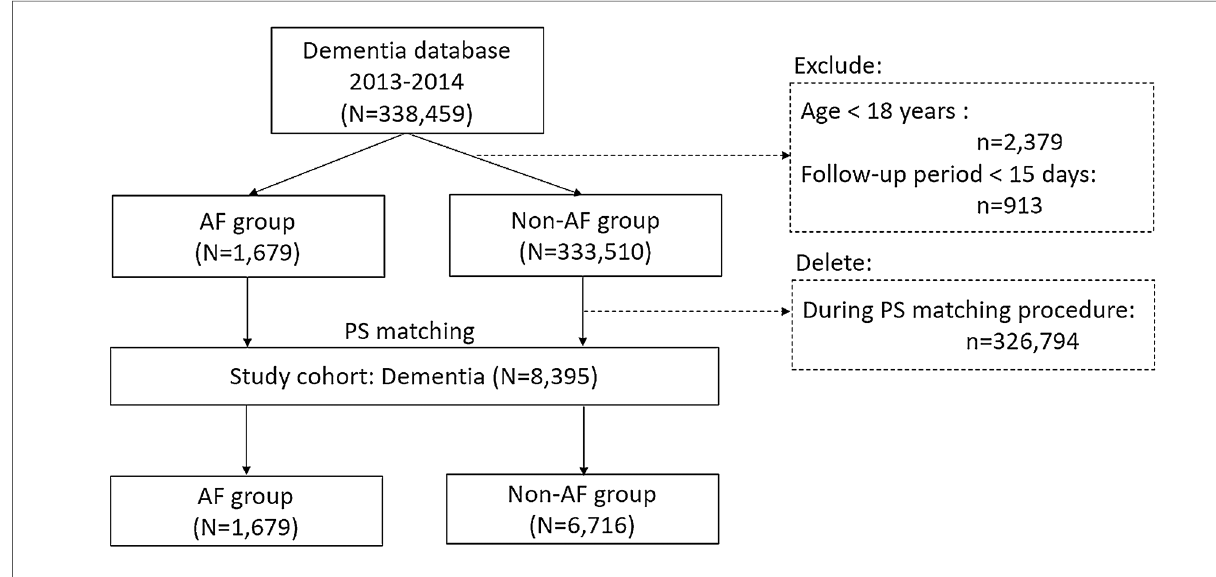
FIGURE 1 Study fl ow chart. N or n, number; PS,